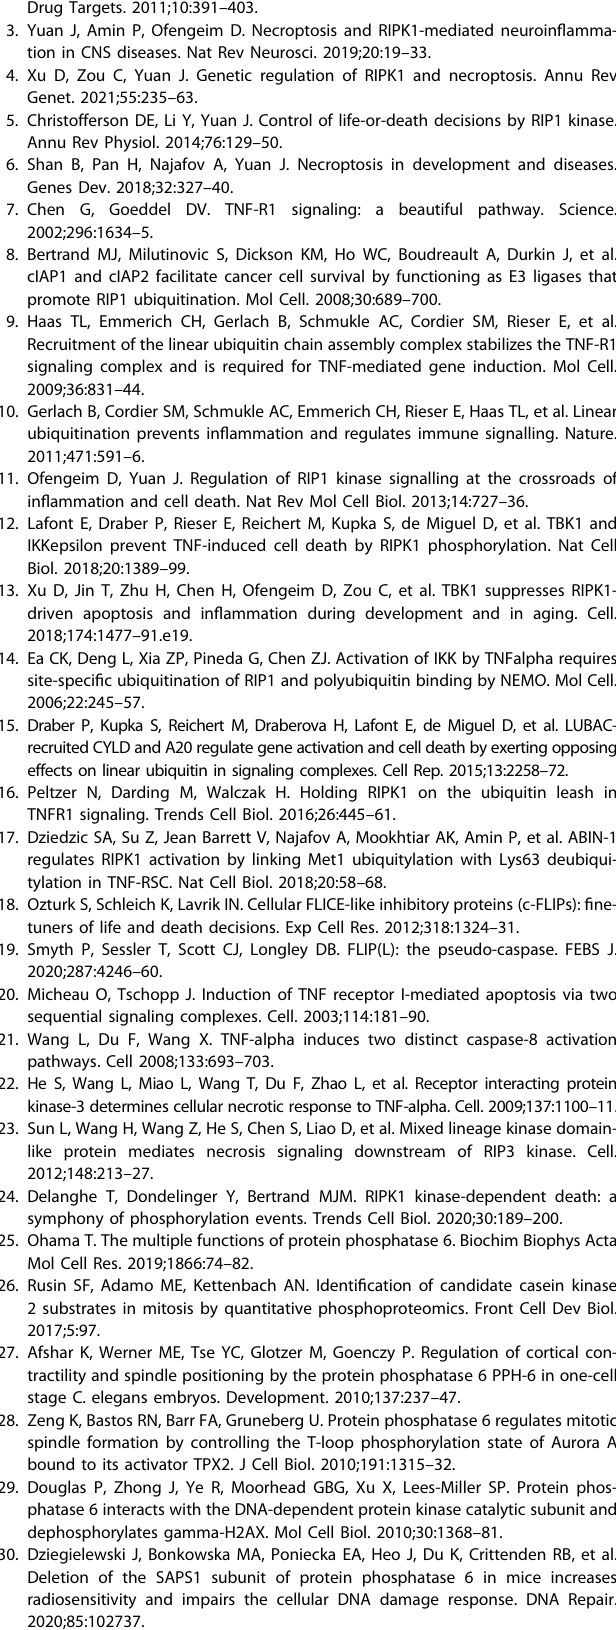
Statistics All cell viability results were processed using GraphPad Prism 7. Results shown depict the mean (±s.e.m.) of at least three independent biological replicates. P values were calculated by two-tailed Student ’ s t test (* P < 0.05; ** P < 0.01; *** P < 0.001; **** P < 0.0001). Each individual experiment was repeated at least 3